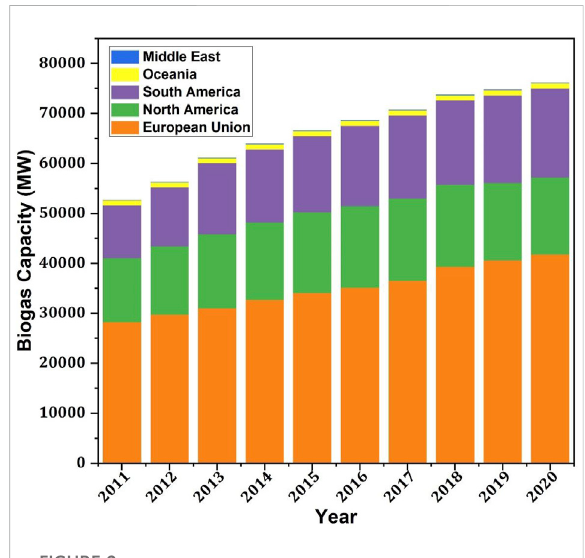
FIGURE 2 Regional breakdown of global biogas capacity (RENA,